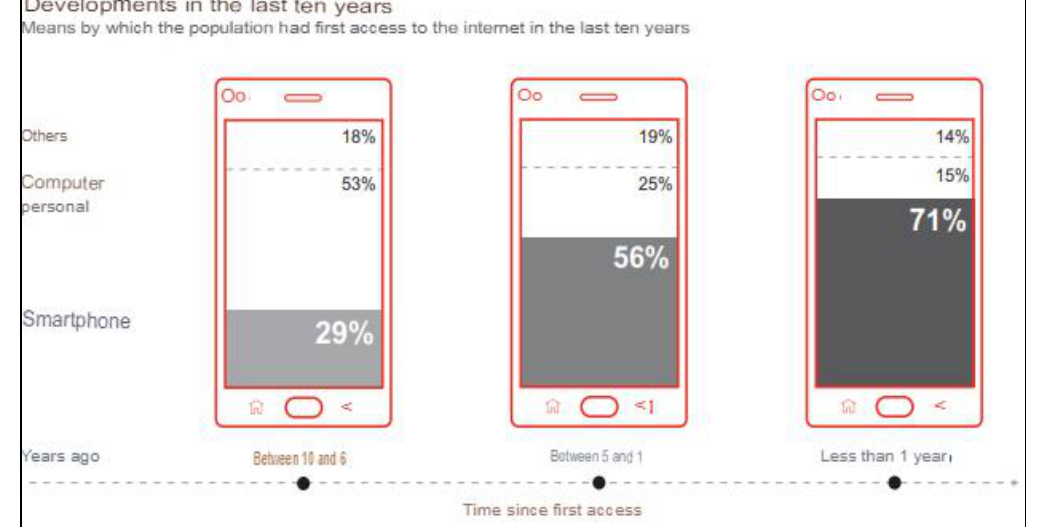
Figure 9: Internet access by Android